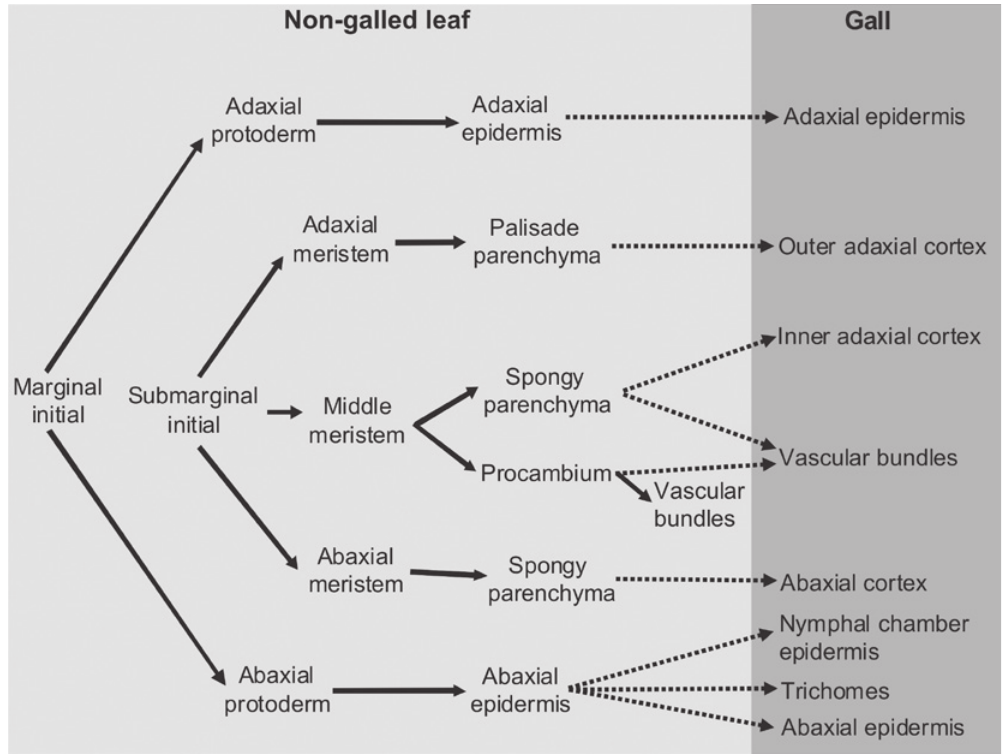
Fig. 3 - Diagrammatic representation of leaf morphogenesis (solid arrows) and of Calophya duvauae gall formation (dotted arrows) on Schinus polygamus